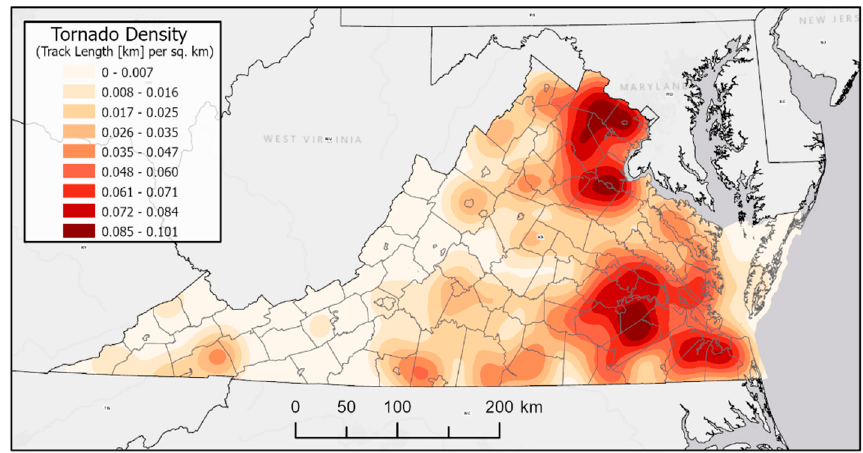
Figure 6. Kernel density analysis of Virginia tornadoes.